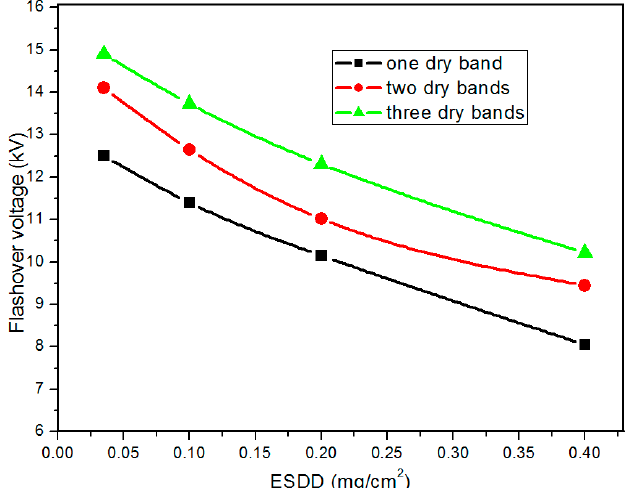
Figure 18. Flashover voltage at different number of dry bands, where NSDD = 0.75 mg/cm 2 , humidity level = low, temperature = 10 °C, and standard deviation = 2.8%–6.5%.